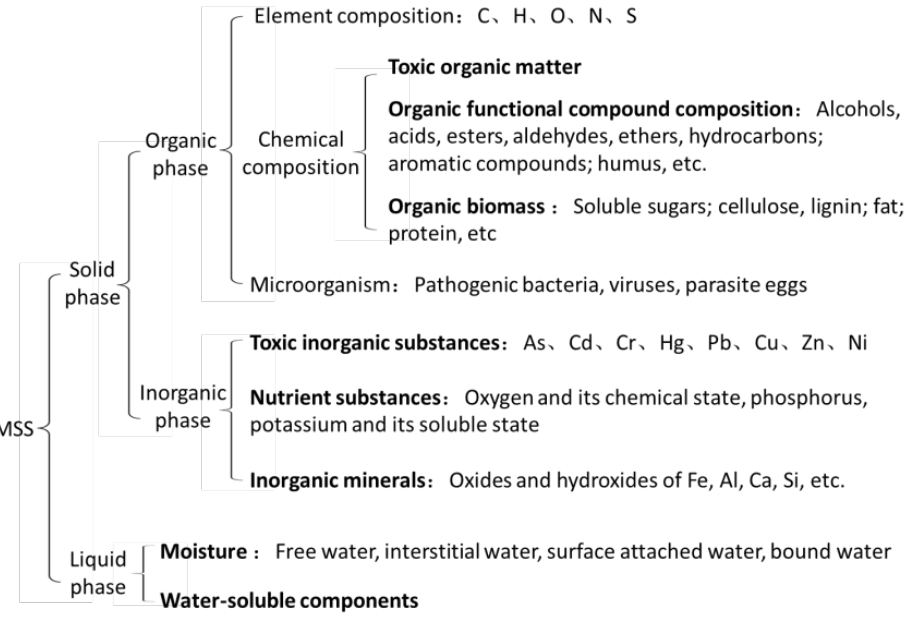
Figure 1. Composition of municipal sewage sludge.